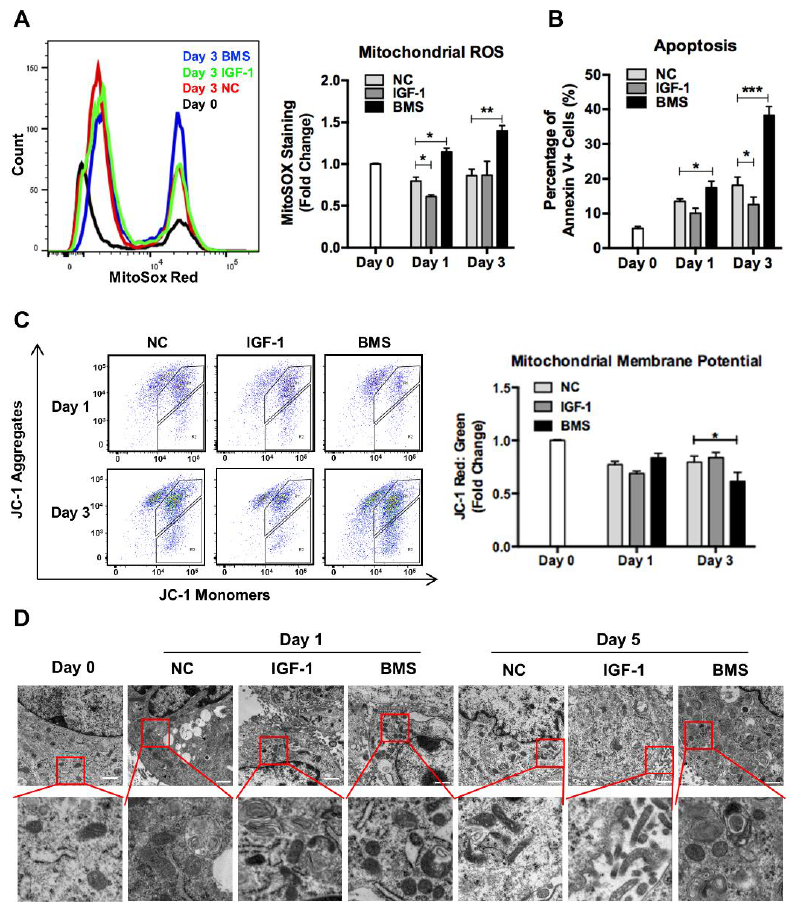
Figure 2. Inhibition of IGF-1 signaling leads to mitochondrial dysfunction and damage. ( A ) Repre- sentative flow charts and quantitative analysis of mitochondrial ROS levels in DMSO, IGF-1, and BMS-C2C12 that were stained with MitoSoX cells during differentiation. ( B ) Quantitative analysis of apoptotic (Annexin V+) cells during differentiation. ( C ) Quantitative analysis of the JC-1 red: green fluorescence ratio with FACS during differentiation. ( D ) Electron micrographs of dif- ferentiating C2C12 cells. Scale bar = 1 µ m. Data represent means ± SD. * p < 0.05, ** p < 0.01, and *** p < 0.001. Abbreviations: ROS, reactive oxygen species; JC-1, 5,5 (cid:48) ,6,6 (cid:48) -tetrachloro-1,1 (cid:48) -3,3 (cid:48) - tetraethyl-benzimidazolylcarbocyanine